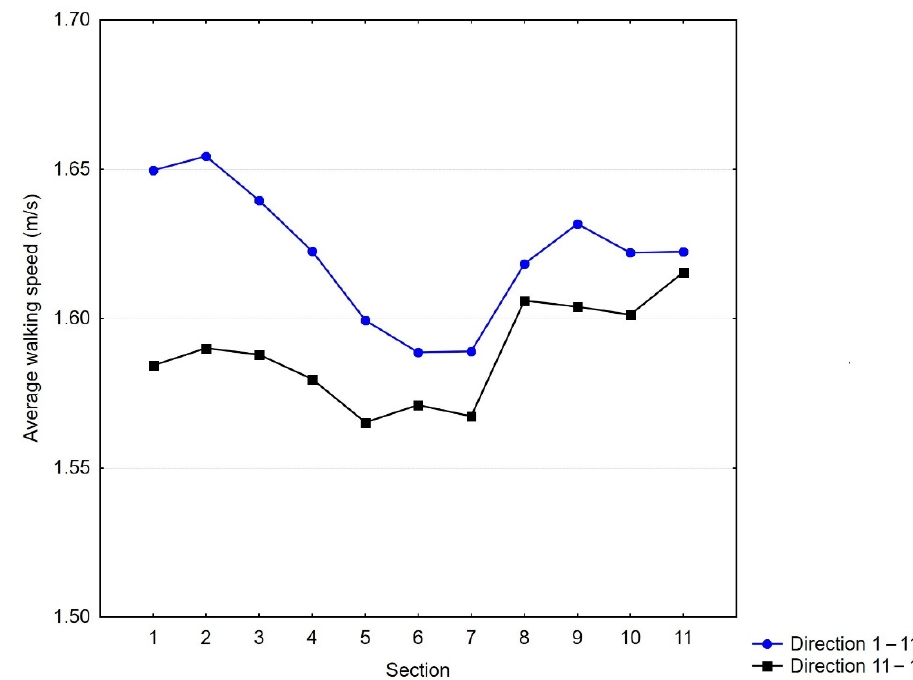
Figure 2. Average walking speeds (m/s) in specific sections of the route in Study 1.